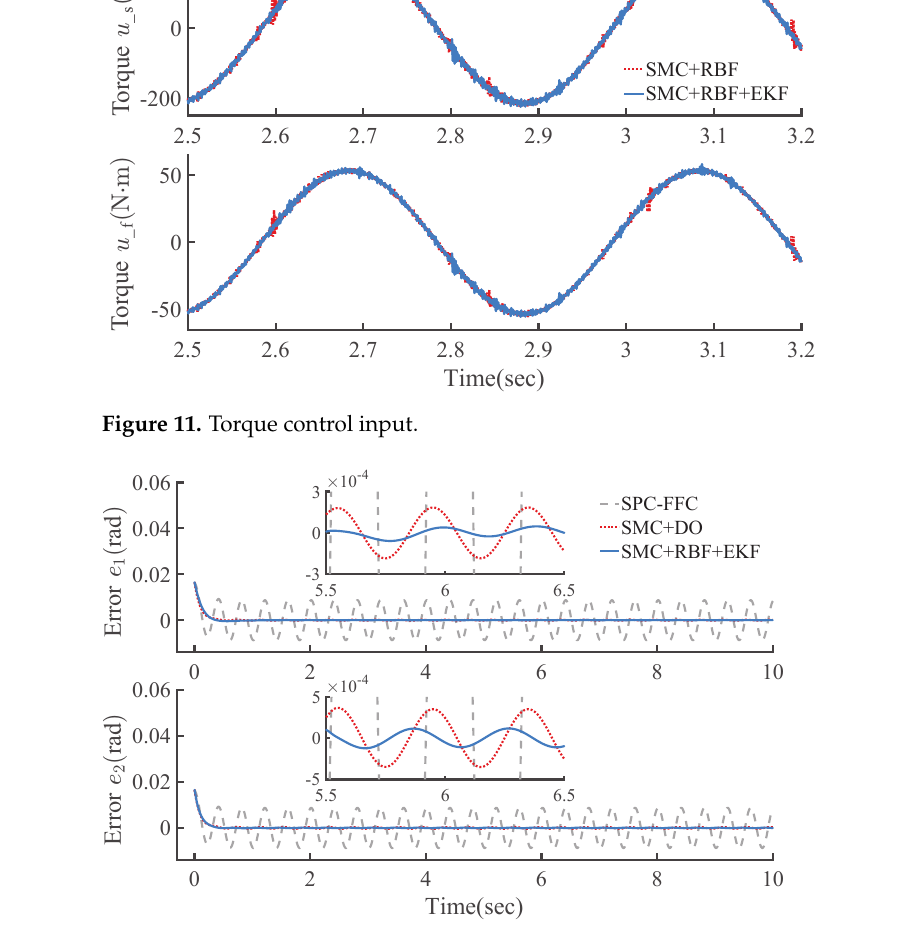
Figure 12. Trajectory tracking error e